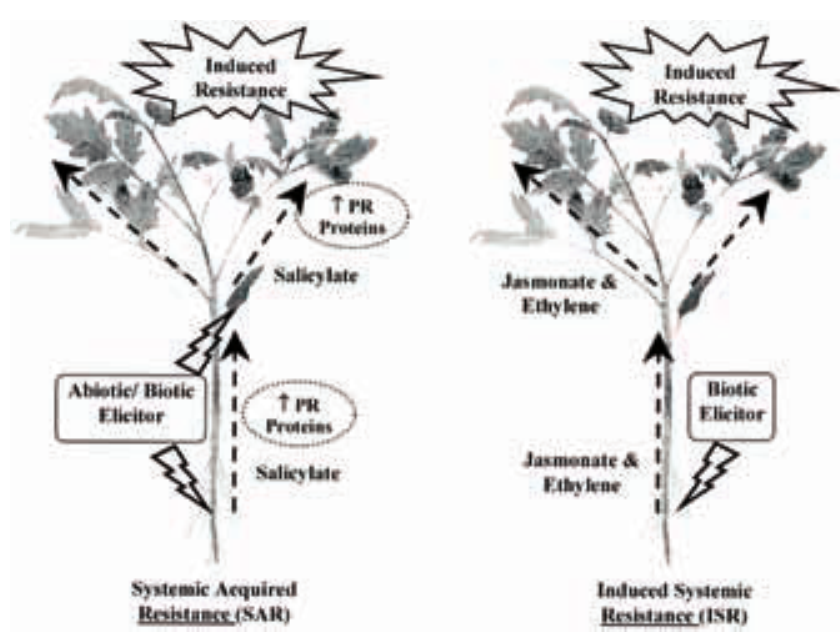
Figure 2. Signal transduction pathways for systemic acquired resistance (SAR) and induced systemic resistance (ISR). Source (Vallad and Goodman, 2004)